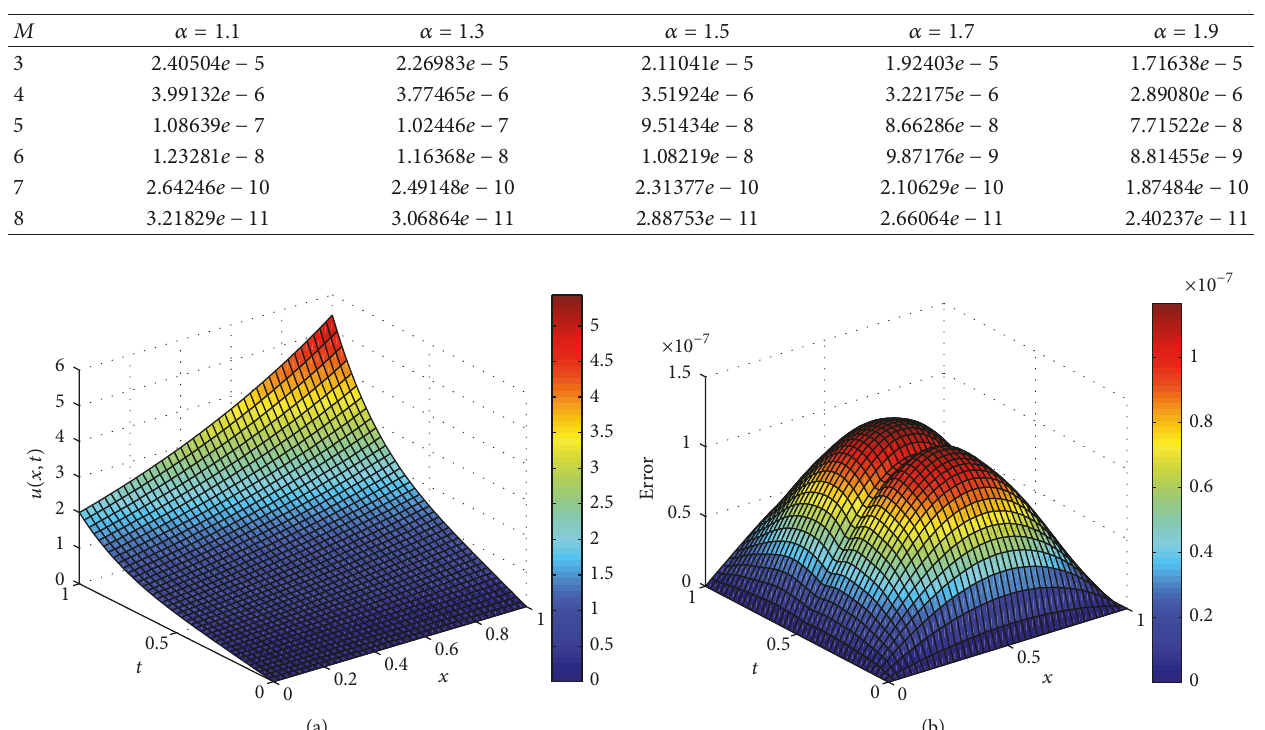
Table 7: Maximum absolute error for Example 3 with various choices of 𝑀 and 𝛼 .